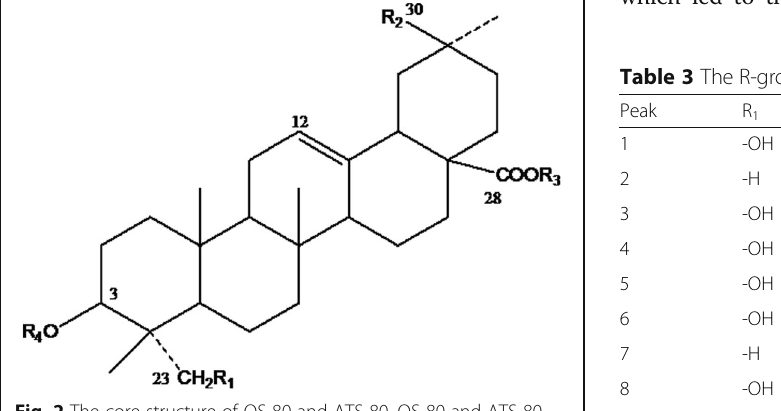
Fig. 2 The core structure of QS-80 and ATS-80. QS-80 and ATS-80 were the 80% methanol-eluted fractions from quinoa saponin and alkali-transformed quinoa saponin, respectively